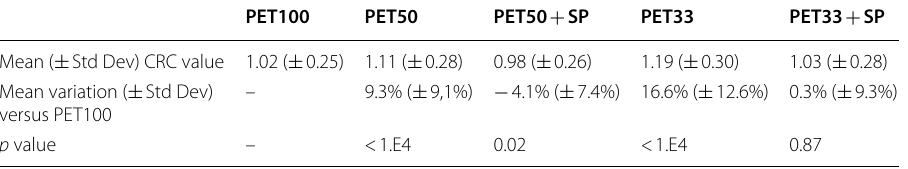
p values of the paired t test between the CRC values for PET100 and the corresponding CRC for the 4 acquisitions/ reconstructions are given